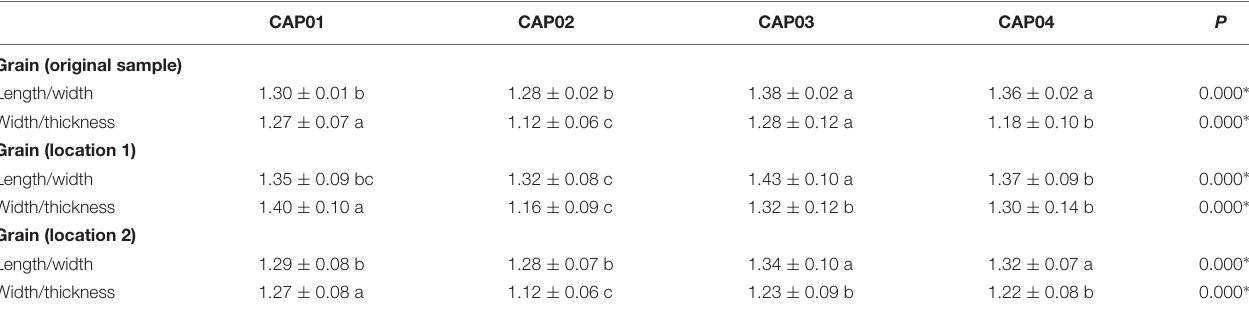
TABLE 2 | Mean values for selected grain parameters in four Caparrona de Monzón bean accessions (CAP01, CAP02, CAP03, and CAP04) grown in two locations (1: Montañana and 2: Monzón).